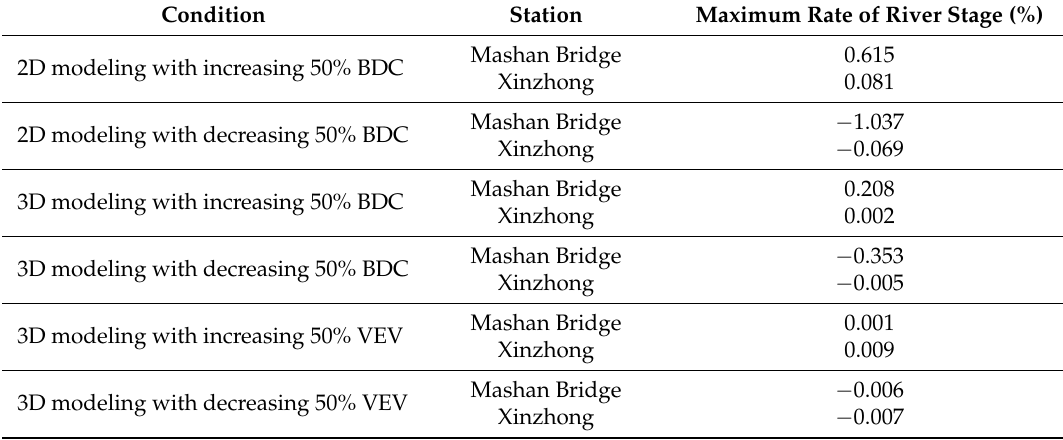
Table 3. The influence of model sensitivity runs on river stage under low flow condition.